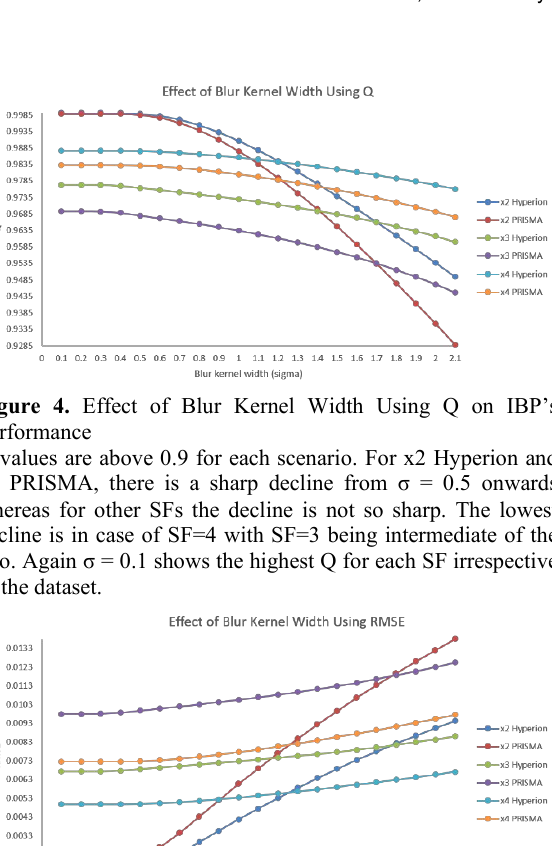
Figure 8. Effect of Blur Kernel Width Using CC on IBP’s Performance CC values are above 0.9 for each scenario. For x2 Hyperion and x2 PRISMA, there is a sharp decline from σ = 0.5 onwards whereas for other SFs the decline is not so sharp. The lowest decline is in case of SF=4 with SF=3 being intermediate of the two. Again σ = 0.1 shows the highest CC for each SF irrespective of the dataset